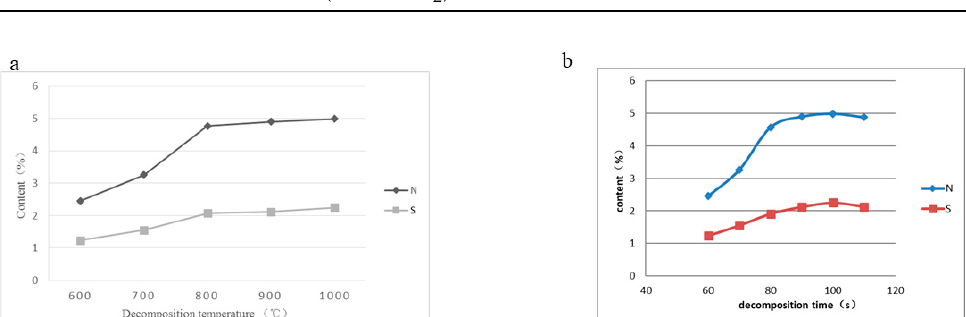
Figure 2. Effect of decomposition temperature and time on N and S contents. The GBW10023 CRMs of nori had a N concentration of 5.0 ± 0.3% and a S concentration of 2.26 ± 0.14%. For Panel ( a ), it was measured by the TCD using different decomposition temperatures. For Panel ( b ), it was measured using different decomposition times. Other experimental conditions were performed as per Table